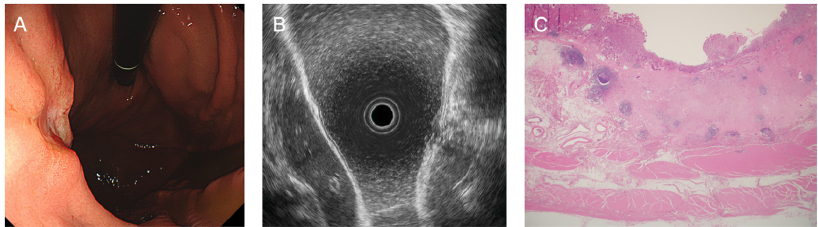
Figure 2. Endoscopic and pathologic figure of submucosal cancer. (A) The lesion was observed with white-light endoscopy; (B), EUS reveals a hypoechoic tumor disrupting the submucosal layer; (C) the histological examination after endoscopic resection demonstrated that the tumor invaded the submucosal layer (T1b). EUS, endoscopic